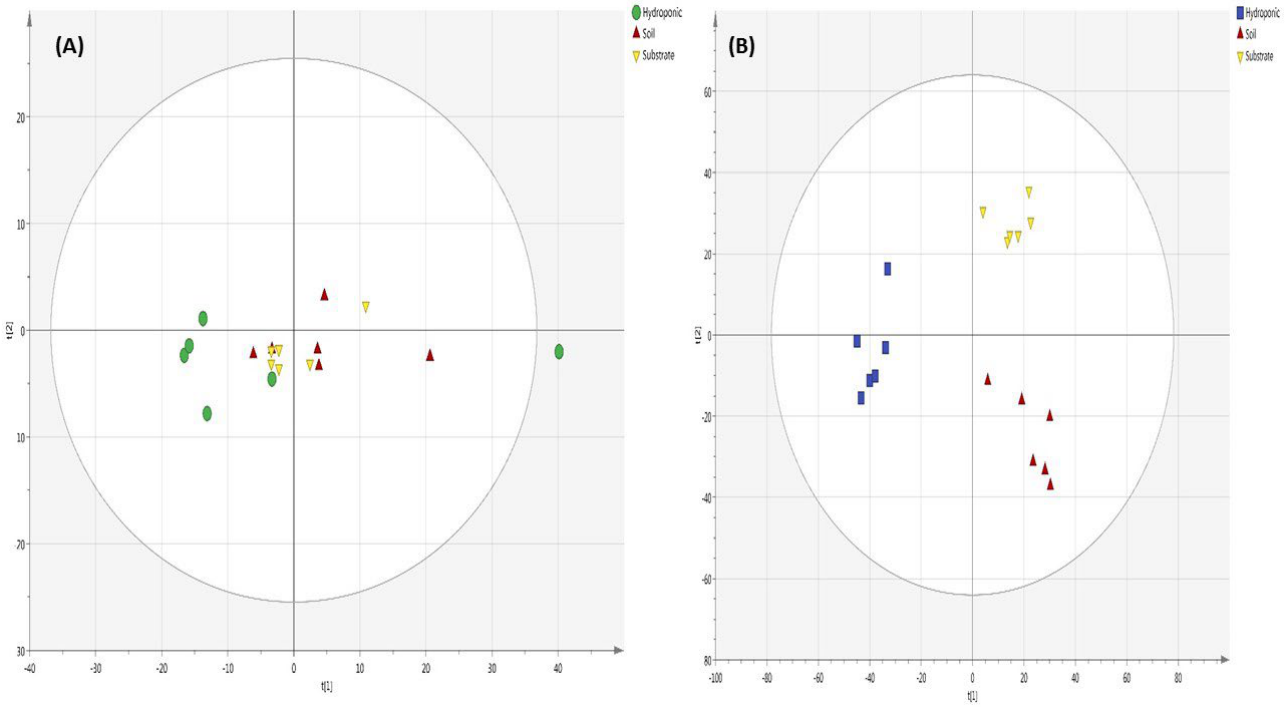
Figure 9. PLS-DA analysis of whole metabolomic profiling of lettuce through GC-MS and UPLC VION IMS QTOF-MS/MS analysis by combining means of all different applied NH 4+ /NO 3 − ratios (100:0, 75:25, 50:50, 25:75 and 0:100%) and control (no additional N applied) in soil, substrate and hydroponic cultivation systems. Note- ( A ) PLS-DA analysis using GC-MS in which green color represents hydroponically grown lettuce, red color represents soil-grown lettuce and yellow color represents substrate-grown lettuce; ( B ) PLS-DA analysis using UPLC VION IMS QTOF-MS/MS in which blue color represents hydroponically grown lettuce, red color represents soil-grown lettuce and yellow color represents substrate-grown